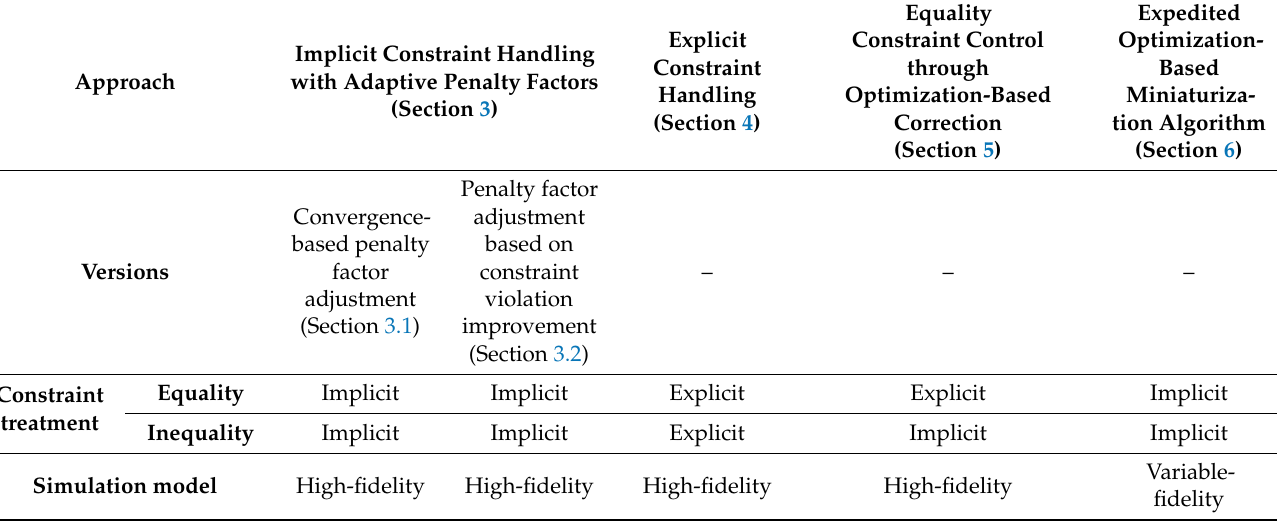
Table 7. Main features of the considered miniaturization